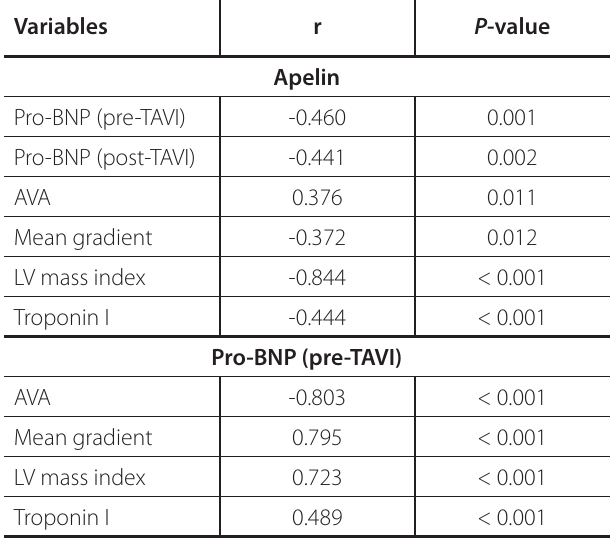
Table 2 . Correlation between serum apelin and Pro-BNP levels and echocardiographic parameters.